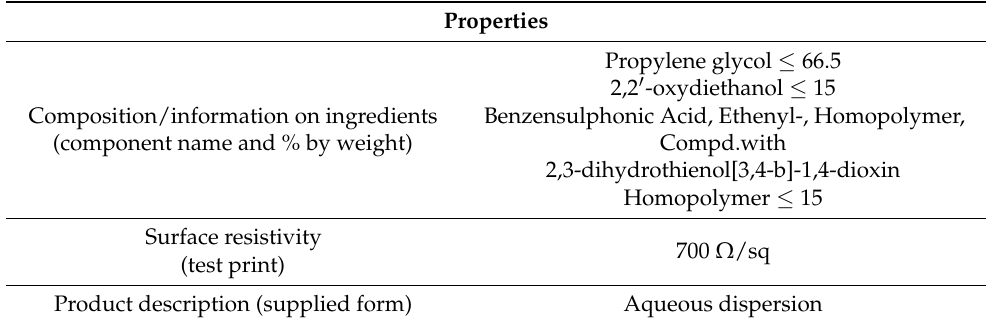
Table 3. Properties of conductive paste applied (product supplier information)